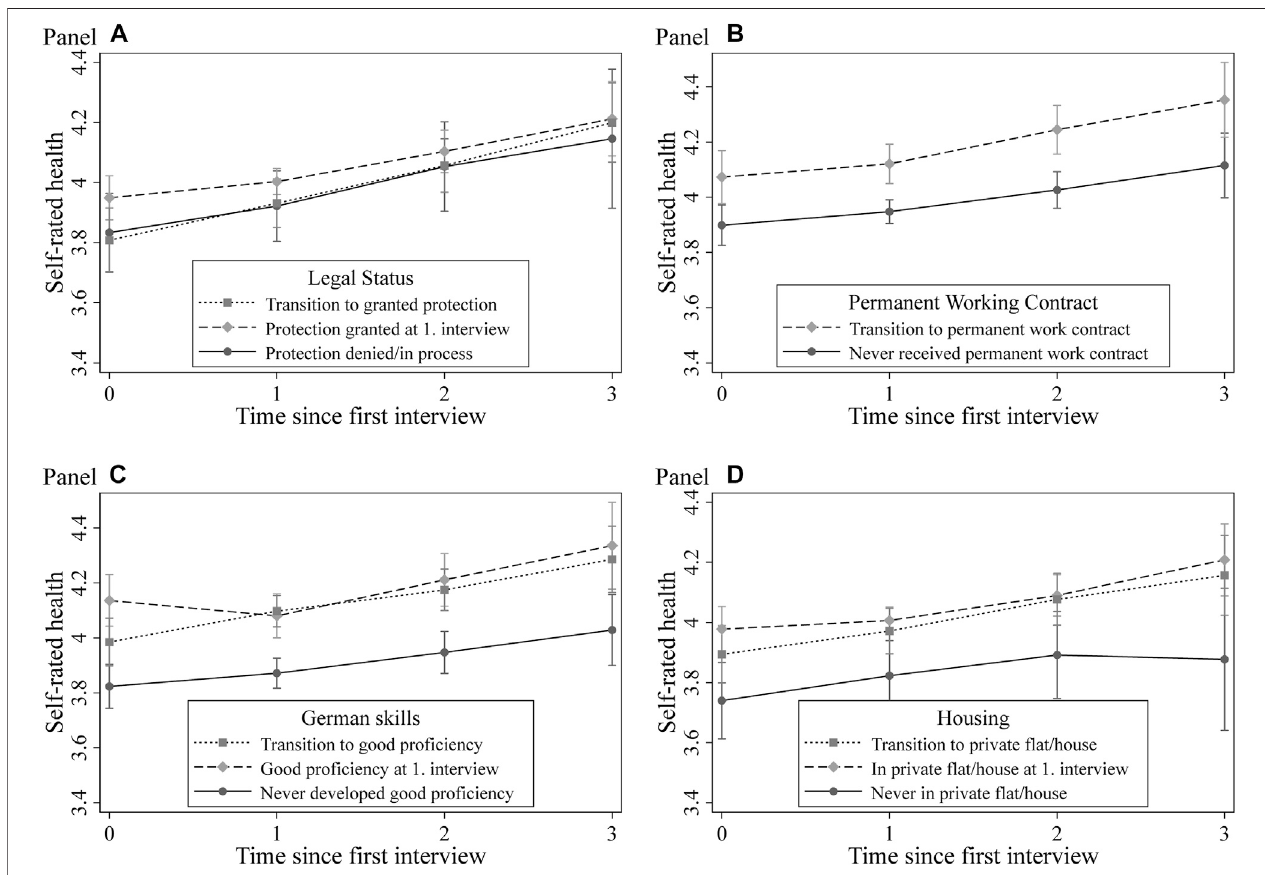
FIGURE 3 | Development of self-rated health by postarrival mechanism. Note . Conditional pro fi le plots of postarrival mechanisms on self-rated health by random effects growth curve models. Full regression results in Supplementary Table S8 (model S8.2 to S8.5). Dependent variables: Self-rated health (1 – 5). Control variables: gender, age, socioeconomic status before migration, arrival year, highest professional educational attainment, survey year fi xed effects, federal state fi xed effects, third person present at the interview, dummies indicating the number of interviews (panel conditioning), indicator for answering sensitive questions, and indicators for missing values in independent variables. Data : IAB-BAMF-SOEP Survey of Refugees, waves 1 –